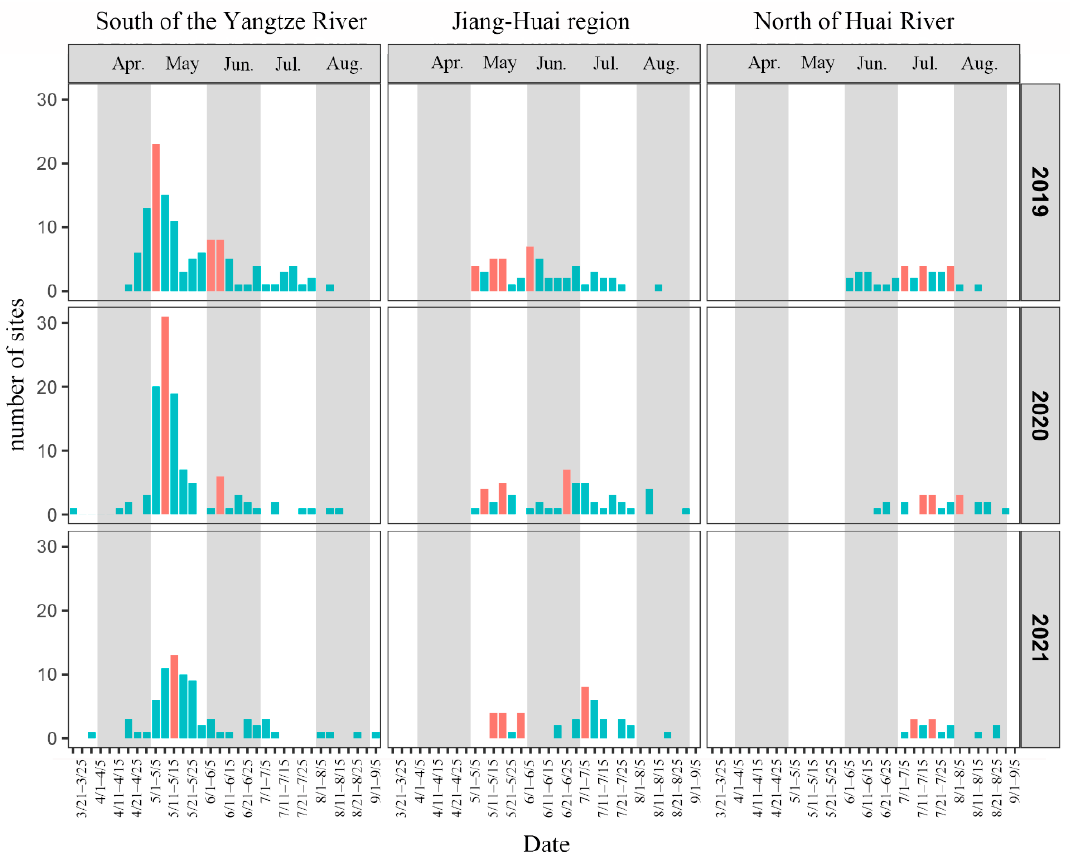
Figure 2. Immigrating timing distribution of Spodoptera frugiperda in the Yangtze River Delta from 2019 to 2021. The red bar in the figure represents the immigration peak.